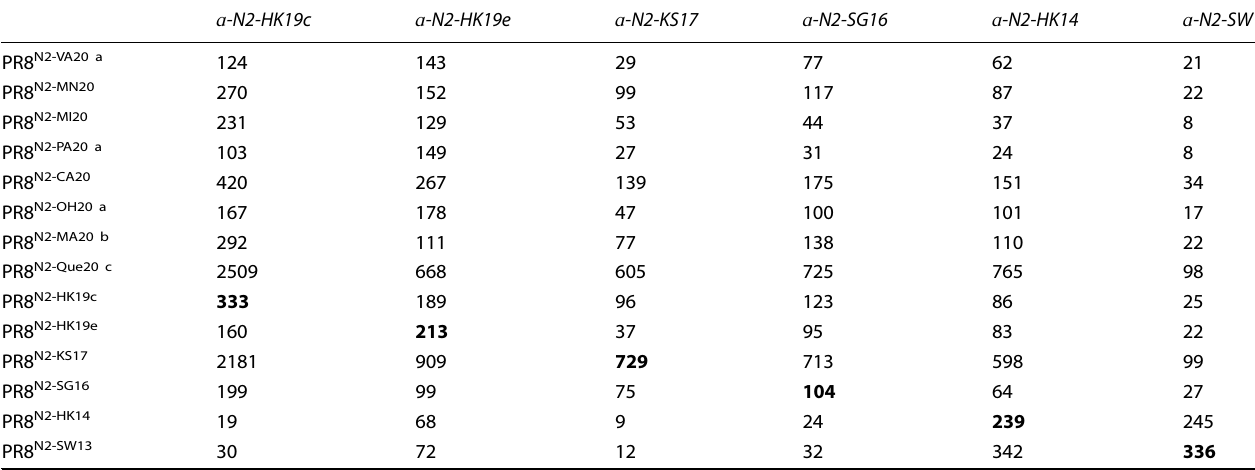
Table 3. NAI titres from the indicated N2 reassortant viruses and antisera. ɑ -N2-HK19c ɑ